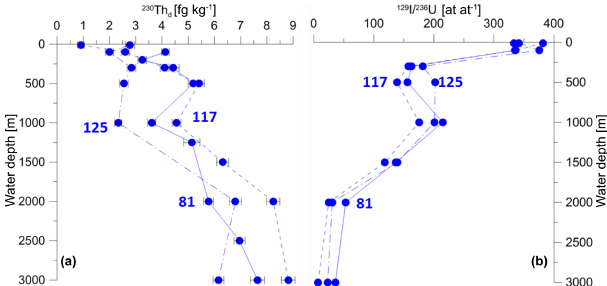
Figure 3. (a) Dissolved 230 Th and (b) 129 I / 236 U (Casacuberta et al., 2018) for three stations in the Amundsen Basin, 2015.